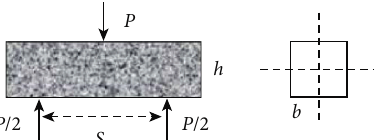
Figure 2: Schematic diagram and cross-section of three-point bending